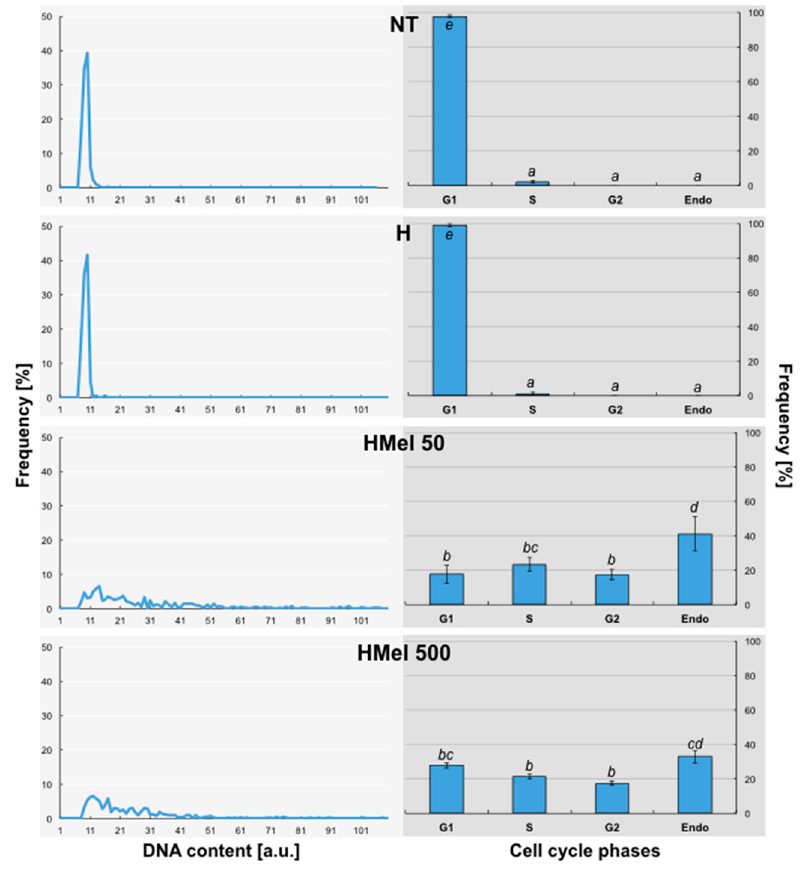
Figure 11. Effect of different maize seed hydropriming treatments on DNA content (line charts) and relative number of cells in G1, G2, S and > 4C phases/Endo (bar graphs) in the axes isolated from non-treated seeds (NT), and those from hydroprimed with water (H) and with melatonin water solutions in concentrations: 50 μ M (HMel 50) and 500 μ M (HMel 500). The seeds were imbibed/germinated in water at 5 °C in darkness for 14 days and subsequently regenerated at 25 °C for 1 day (R [ ■ ]—regeneration). The results of cell cycle phase distribution are expressed as means of 5 analyses ±SEM. Two-way ANOVA and Duncan’s post-hoc tests were performed. The lowercase letters next to the values show statistical significance at the specified p . Cell cycle phases distribution—ANOVA results: Seed Variant (NT,H,HMel 50,HMel 500) F (3;64) = 0, p = 1; Cell Phase (G1,S,G2,Endo) F (3;64) = 207.15, p < 0.0000001; interaction Seed Variant x Cell Phase F (9;64) = 78.56, p <